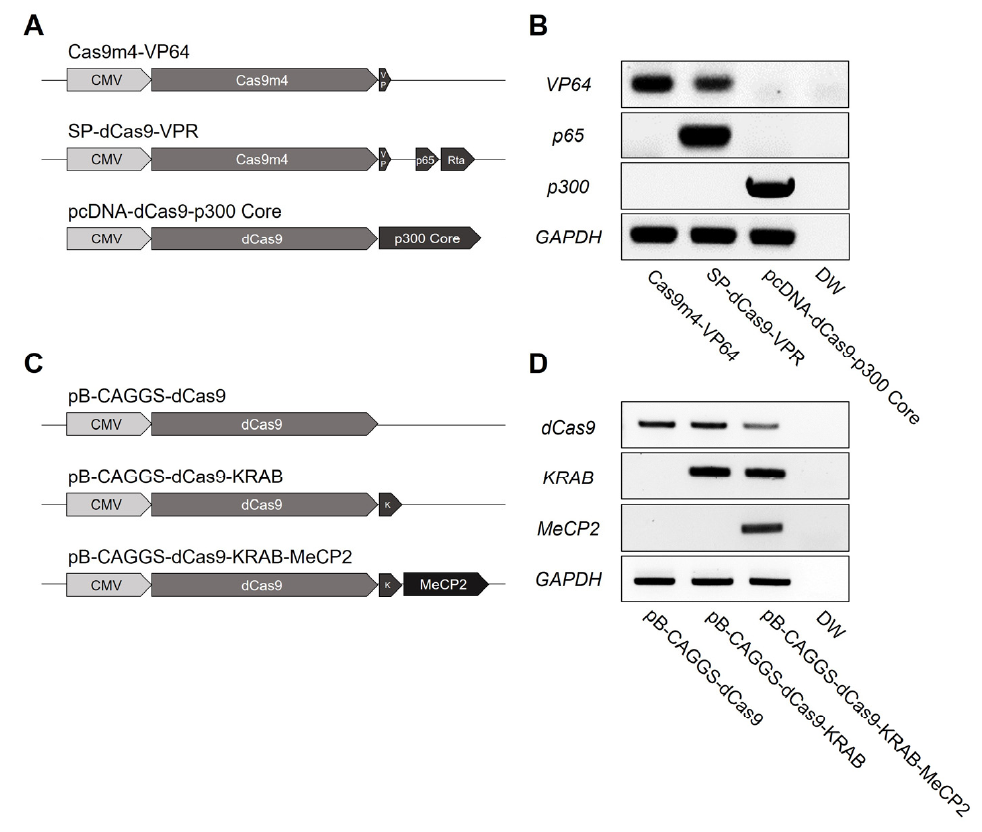
Figure 1. Establishment of CRISPRa and CRISPRi expressing cell lines ( A ) Schematic representation of CRISPRa vectors. CMV, cytomegalovirus promoter; Cas9m4, inactive Cas9 lacking endonuclease activity; VP, activation domain VP64; Rta, Epstein–Barr virus R transactivator; p300 Core, p300 histone acetyltransferase ( B ) RT-PCR analysis in the established CRISPRa DF-1 cell lines. ( C ) Schematic representation of CRISPRi vectors. dCas9, inactive Cas9 lacking endonuclease activity; K, Krüppel- associated box, KRAB; MeCP2, methyl-CpG binding protein 2 ( D ) RT-PCR analysis in the established CRISPRi DF-1 cell lines. The endogenous GAPDH gene was used as a